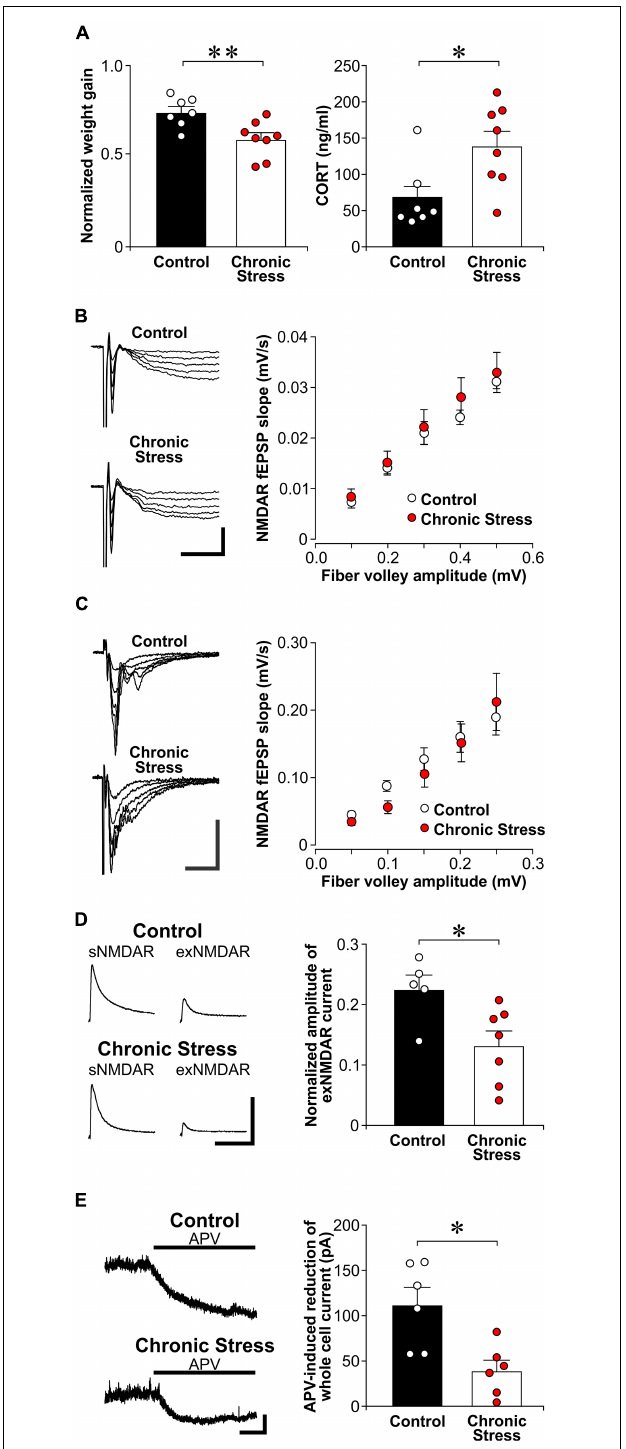
FIGURE 4 | Chronic stress reduces exNMDAR functions. (A) Left: Histograms of normalized weight gain of control ( n = 7) and chronically stressed rats ( n = 8) in 21 days. Right: Histograms of CORT levels in trunk blood in control ( n = 7) and chronically stressed rats ( n = 8) collected right before brain slice preparation. Stressed rats were sacrificed 7 days within the end of chronic